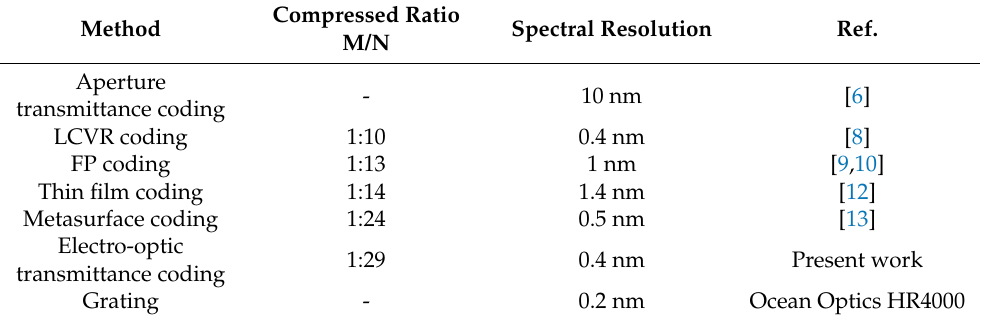
Table 2. Comparison with reported spectrometry